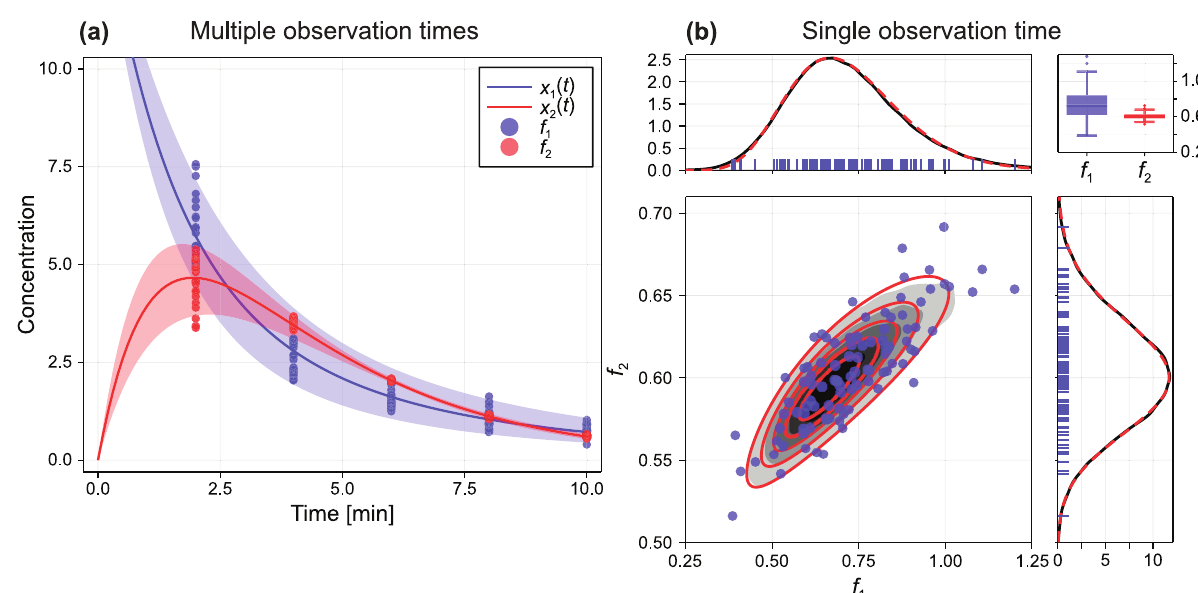
Fig 7. Synthetic data from the non-linear two-pool model. (A) Data comprise N = 20 noisy observations of the concentration in each pool from five observation times. Also shown is the mean and a 95% prediction interval based on the approximate solution to the random parameter non-linear two- pool model. Bivariate data and solution to the random parameter problem are provided as supporting material (Fig C in S1 File) in addition to a statistical comparison for each marginal distribution (Table C in S1 File). (B) Data comprise N = 100 noisy observations from the single observation time t = 10 (blue discs). Also shown is the approximate solution to the random parameter problem using correlated gamma marginals (red solid), and the exact density based on 10 5 randomly sampled parameter values (grey filled).